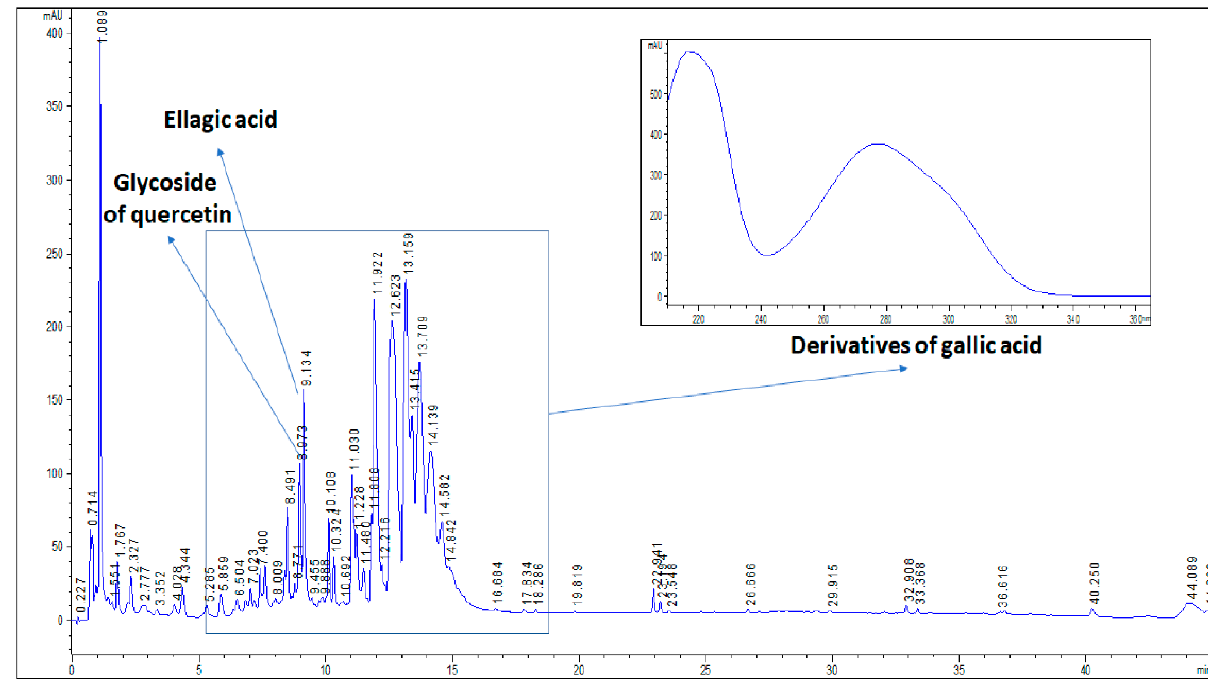
Figure 1. The representative chromatogram of methanolic extract of R. coriaria .